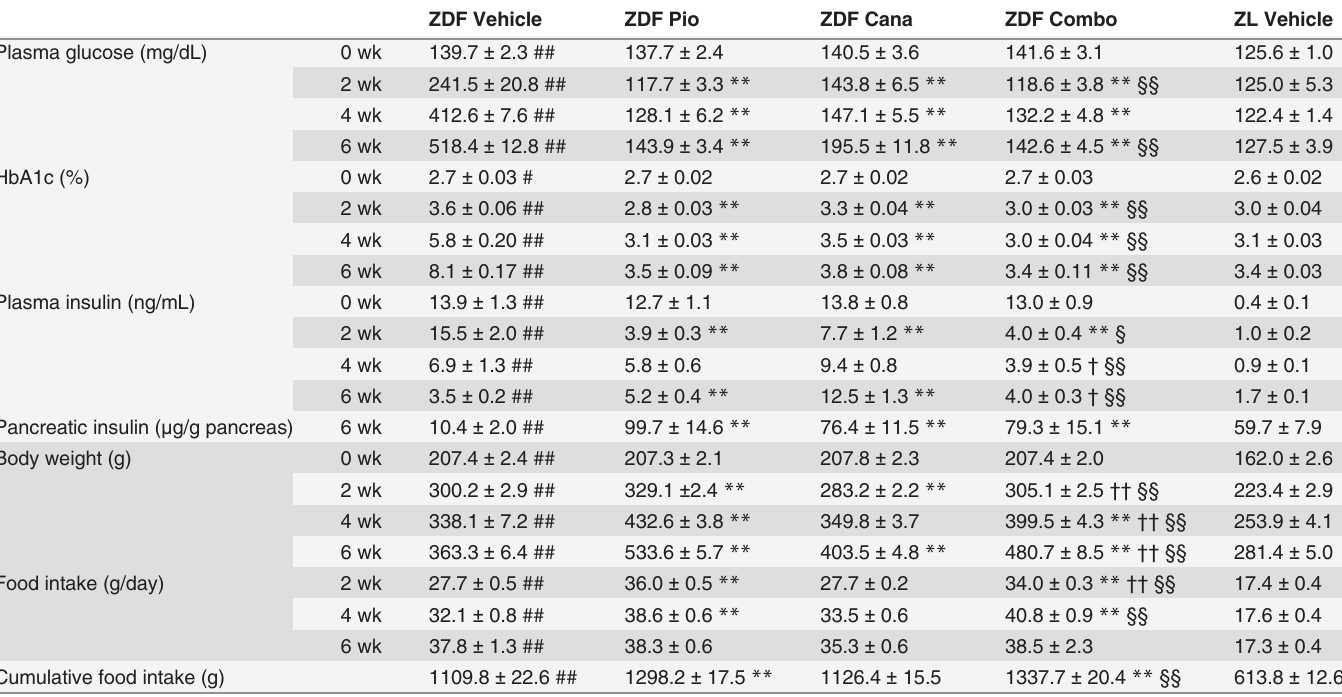
Table 1. Effects of combination therapy on the development of diabetes in ZDF and ZL